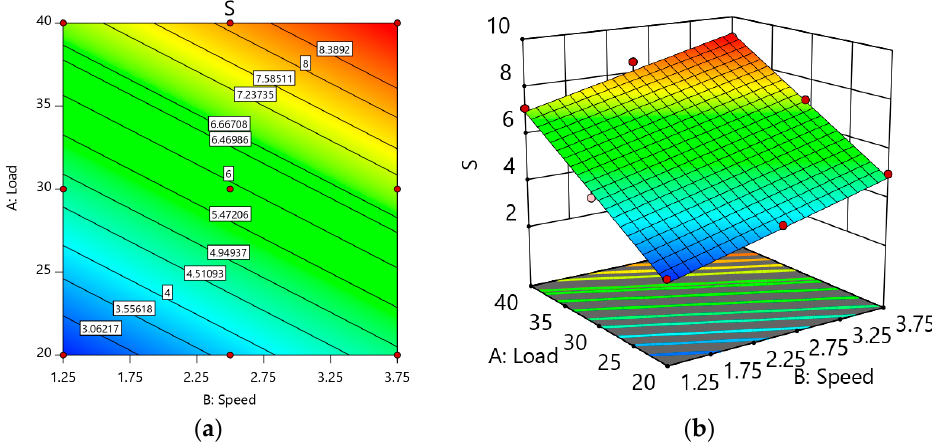
Figure 9. ( a ) 2D Response surface plot effect of load and speed on the weight loss of Sample S; ( b ) 3D Response surface plot effect of load and speed on the weight loss of Sample S.